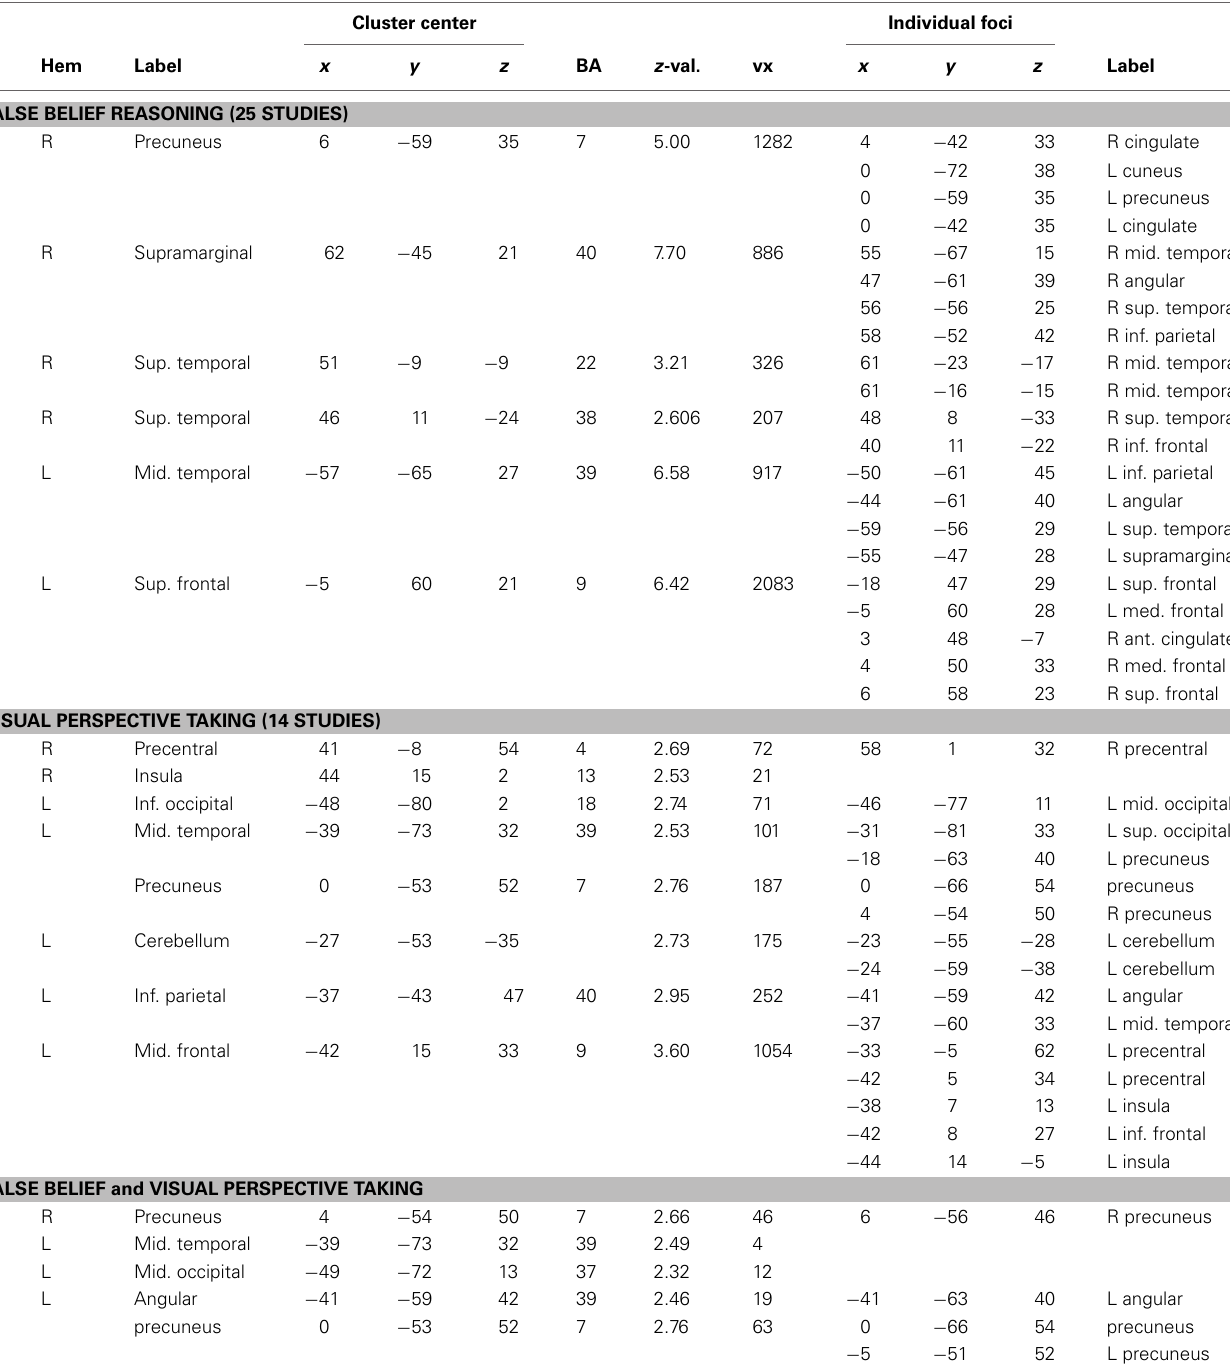
Table 2 | Results of meta-analyses for False Belief Reasoning and Visual Perspective Taking. Cluster center Individual